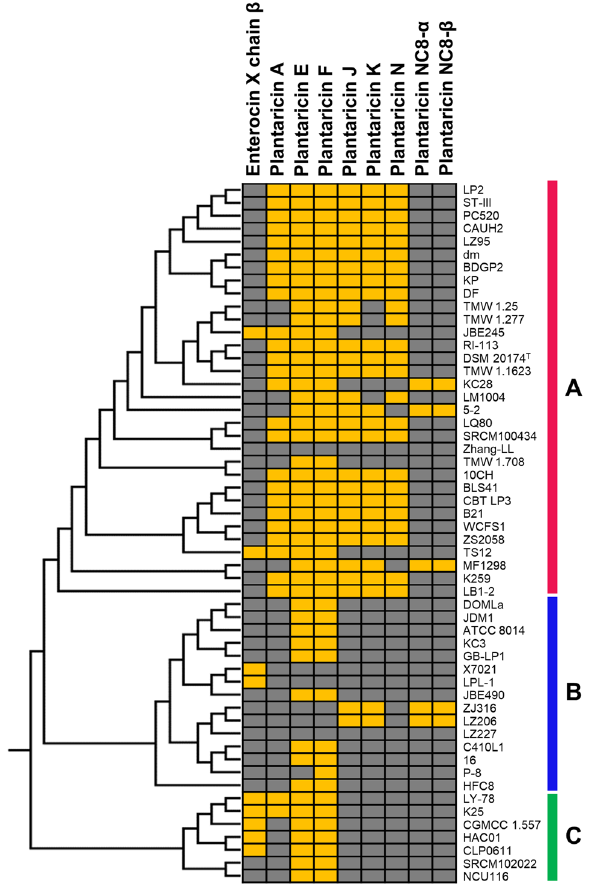
Figure 2. Bacteriocin profiling on the chromosomes of Lactiplantibacillus plantarum subsp. plantarum . The presence (yellow) and absence (gray) of bacteriocin genes are represented in the matrix. The dendrogram was obtained from the phylogenomic tree constructed using RAxML